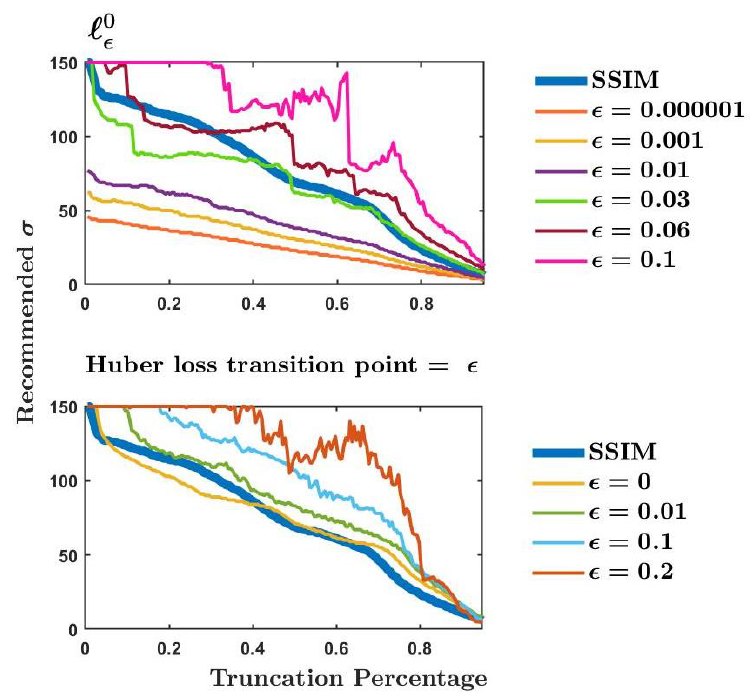
Figure 8. ( top ) SSIM (thick blue) and (cid:96) 0 (cid:101) for various values of (cid:101) . ( bottom ) SSIM (thick blue) and Huber loss for various values of (cid:101)